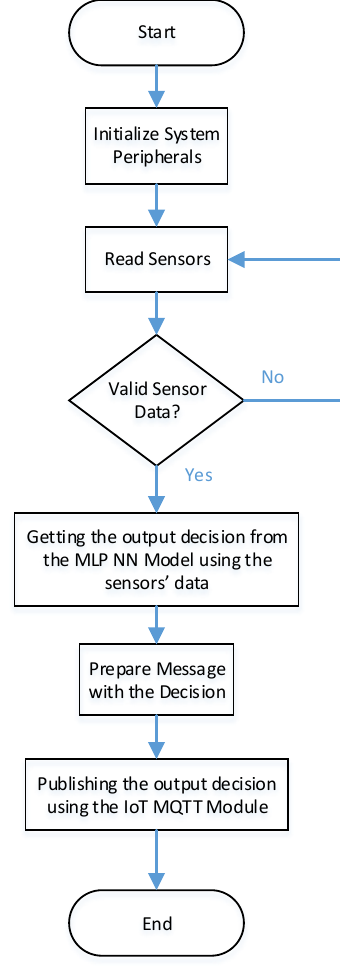
Figure 7. Flow chart of AI-IoT